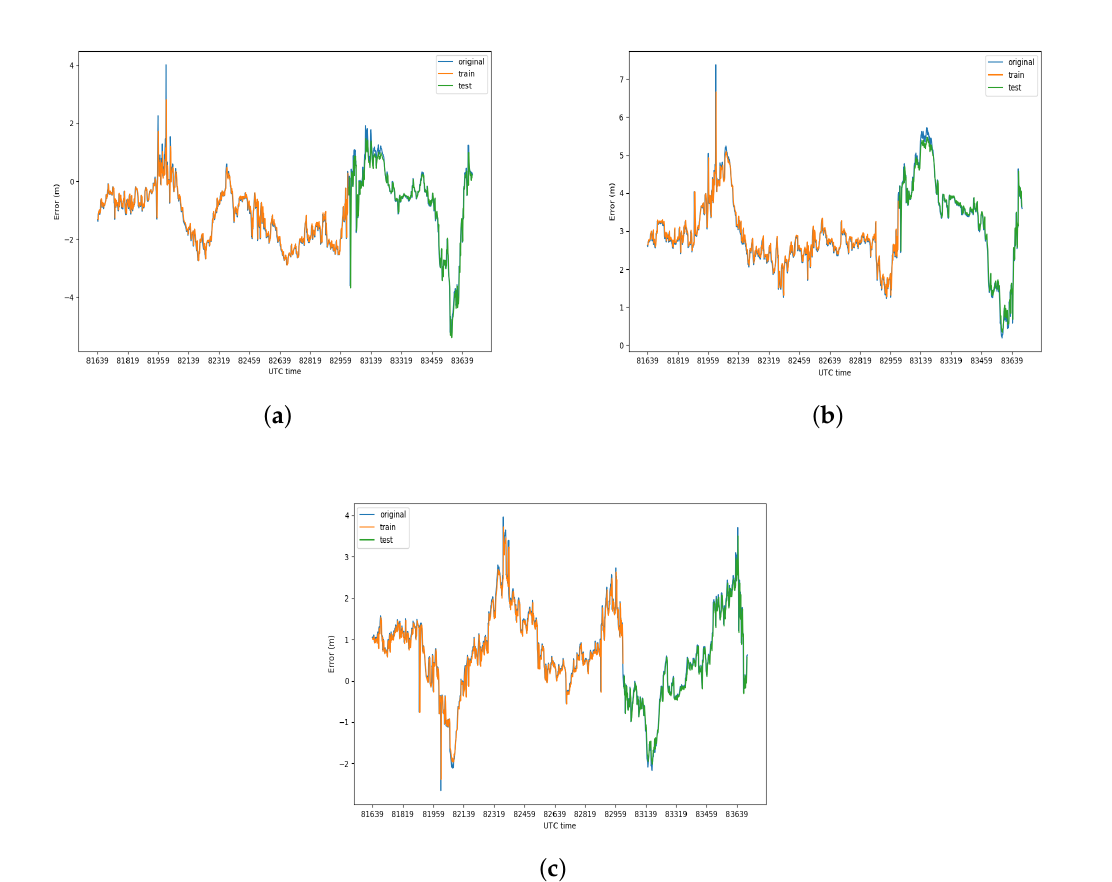
Figure 12. Result of dynamic LSTM error prediction: ( a ) result on X-axis; ( b ) result on Y-axis; and ( c ) result on Z-axis.